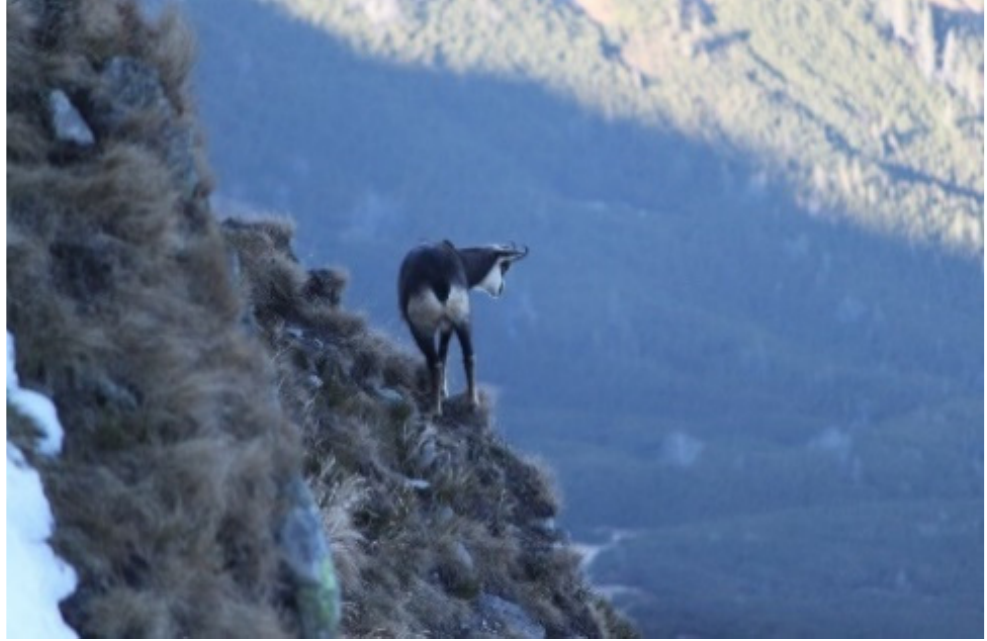
Figure 15. Alpine chamois in its natural environment in the Ď umbier Tatras (photo P. Urban). The size of the area has fluctuated over the years, with no significant differences. In the middle of the reintroduction, the chamois area was 9 km long and 5 km wide, with the centre located in the Skalka area (the site where the chamois were released). Shortly after the end of the reintroduction (1977–1980), the area of the Tatra chamois in the Ď umbier Tatras was almost identical to its current area. It took an area of 2626 ha, from the Ď urková saddle (1751 m) in the west to the end of the Štiavnica Valley near the mountain cabin under Ď umbier in the east, or from Žiarska ho ľ a (1840 m) in the south to Mošnica Valley (Bôrov north depression) in the north. Between 1982 and 1985, the size of the chamois area in the Ď umbier Tatras was planimetrically determined to be 2827 ha, of which the winter habitats occupied only 1301 ha [71]. At present, the chamois habitat forms part of the main ridge of the Ď umbier Tatras, approximately from Chabenec (1955 m) or Ď urková (1749.8 m) in the west to the massif of Štiavnica (2025.3 m) or Králi č ky (1807.4 m) in the east (which is almost 20 kilometres long), and to its lateral north forks (Po ľ ana–Zák ľ uky–Bôr or Ludárova ho ľ a) and southern forks (Kotliská–Skalka–Žiarska ho ľ a, or Kozie chrbty) with adjacent upper limits of the valleys (Lomnistá, Vajskovská, Krížska, Demänovská, Široká, Ludárova, Jánska), mainly in the subalpine and alpine vegetation levels. 5.3. Negative Impact of Tourism on the Distribution of the Alpine Chamois and Its Habitat However, the centre of the chamois area is divided by passenger mountain transport facilities and the Jasná resort (north and south) ski slopes, which were established in the middle of the last century and have been significantly expanded since 2010.